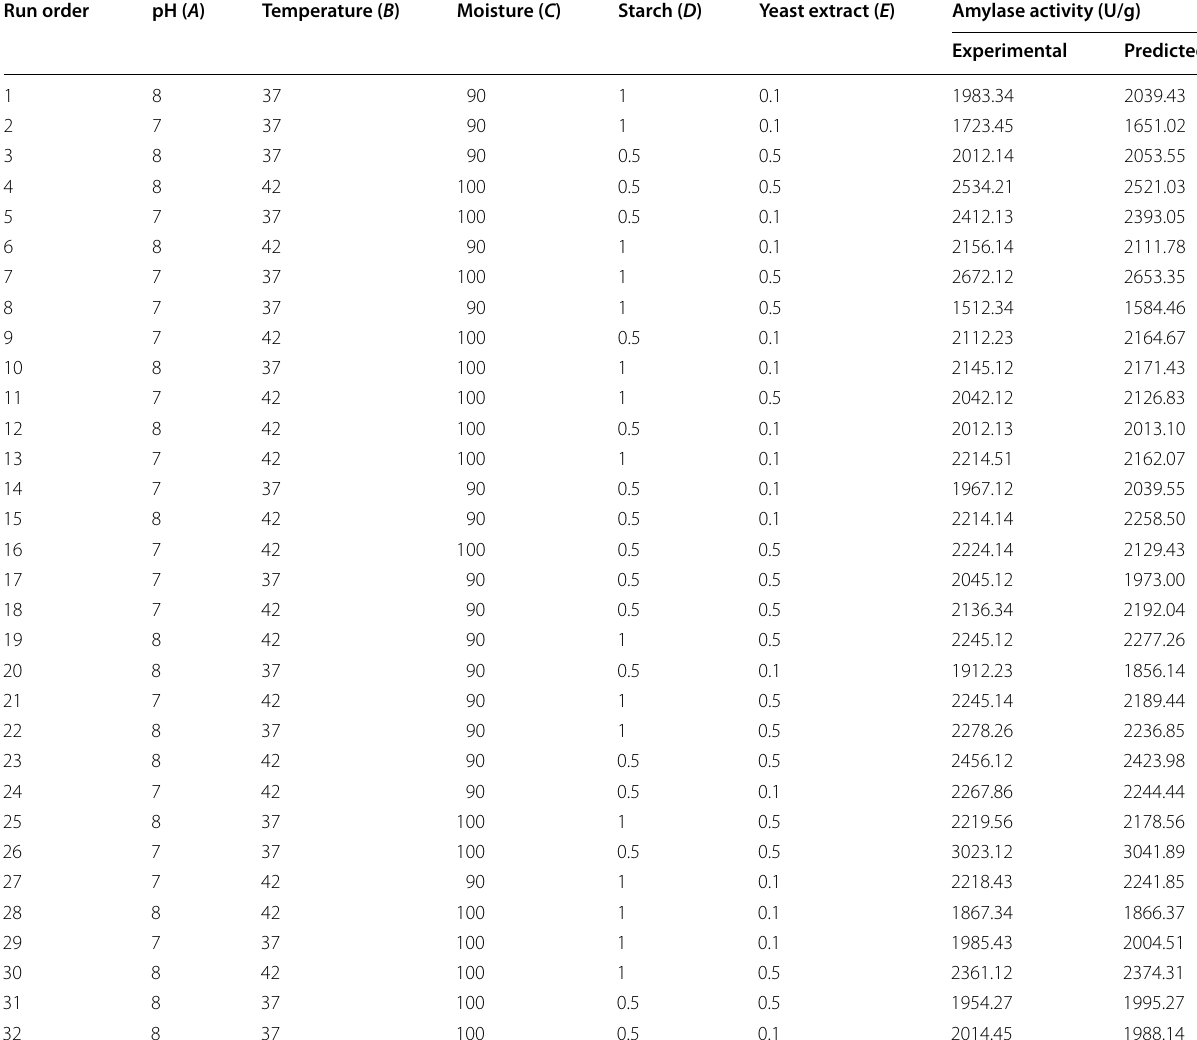
Table 2 Screening of factors for amylase production from strain ALA4 by two-level factorial design Run